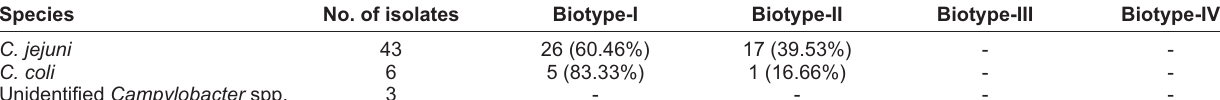
Table-2: Biotyping of